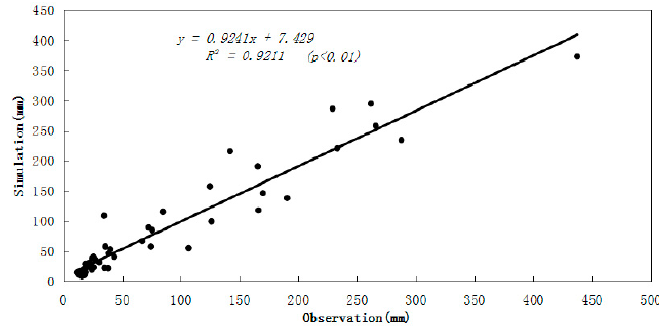
Figure 9. Comparison of monthly runoff between observation and simulation.